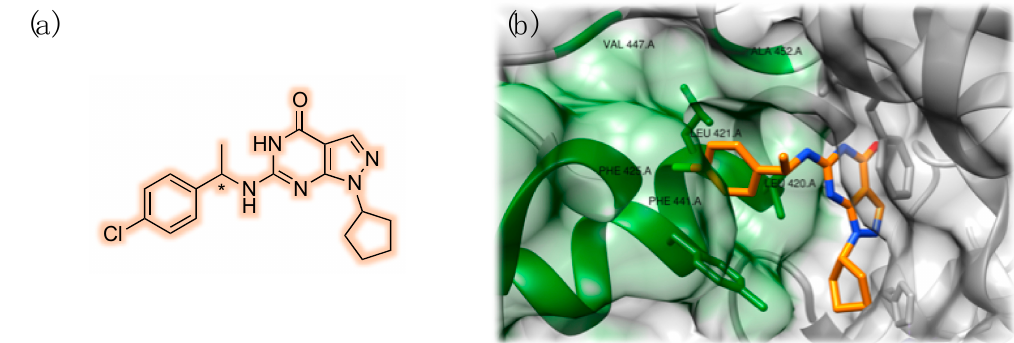
Figure 7. Chemical structure of (S)-C33/(R)-C33 ( a ). Detailed view of the interaction pattern of (S)-C33 with PDE9: the residues forming the specific hydrophobic M-pocket have been labeled and highlighted in green (PDB ID: 4Y8C) ( b ).